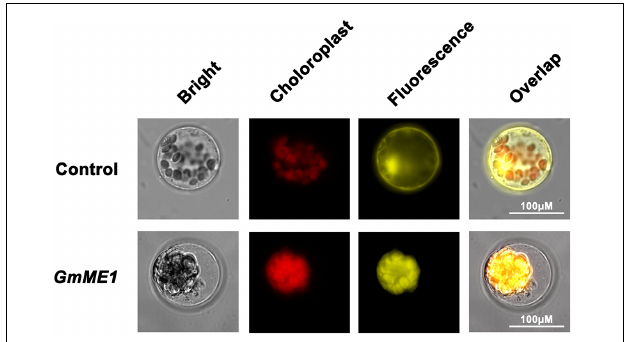
FIGURE 5 | Subcellular localization of GmNADP-ME. The YFP alone (above columns) and fusion protein GmME1:YFP (down columns) were transiently expressed in Arabidopsis protoplasts. The panels show the overlapped images of bright-field, chloroplast, fluorescence images from left to right. Scale bar = 100 µ M.